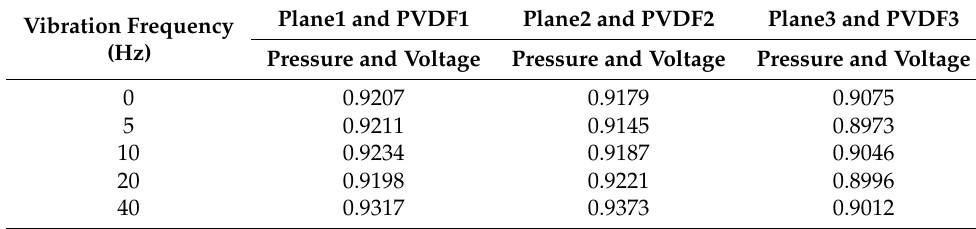
Table 8. Correlation coefficient.